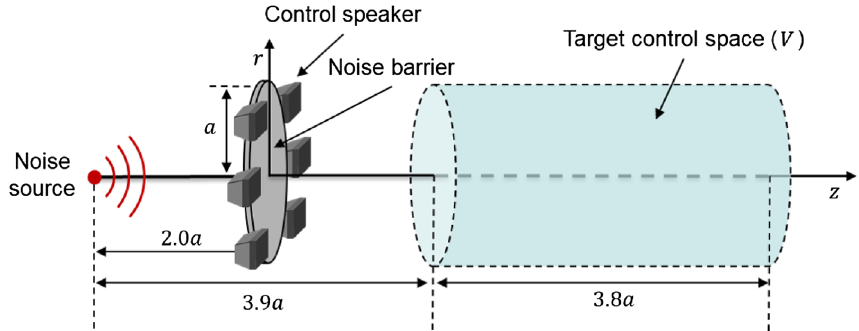
Figure 5. Configuration of the simulation model. A simple speaker model is used for control sources. a is the radius of the barrier. V is the target control